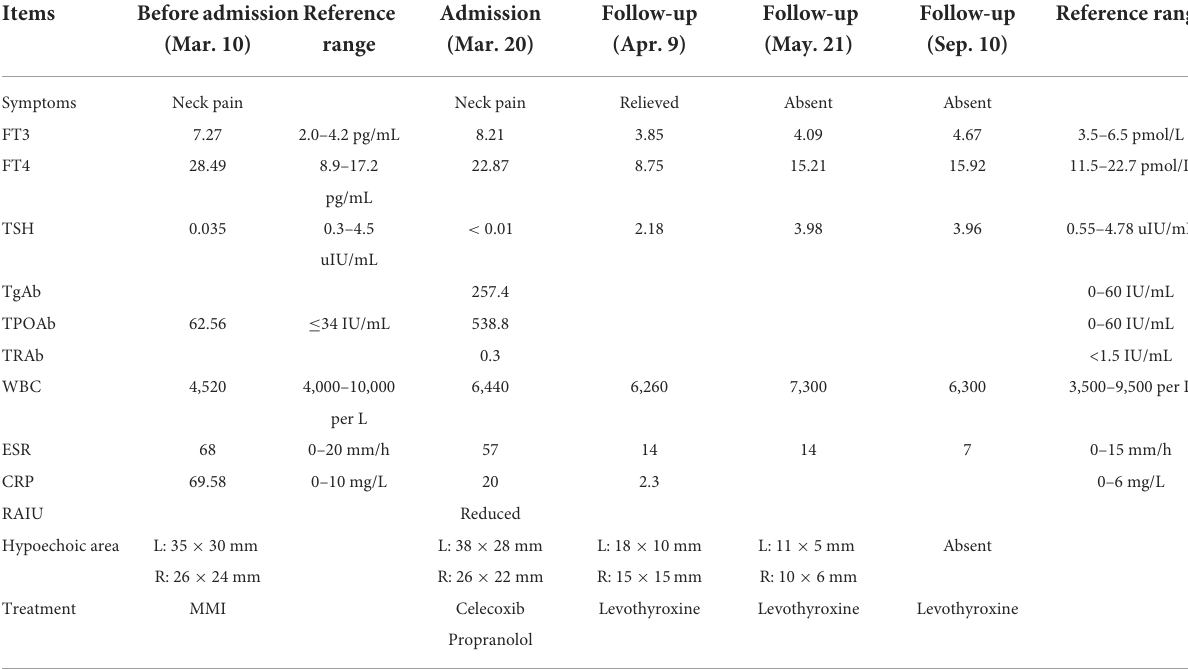
TABLE 1 Clinical, laboratory, imaging findings on admission and during